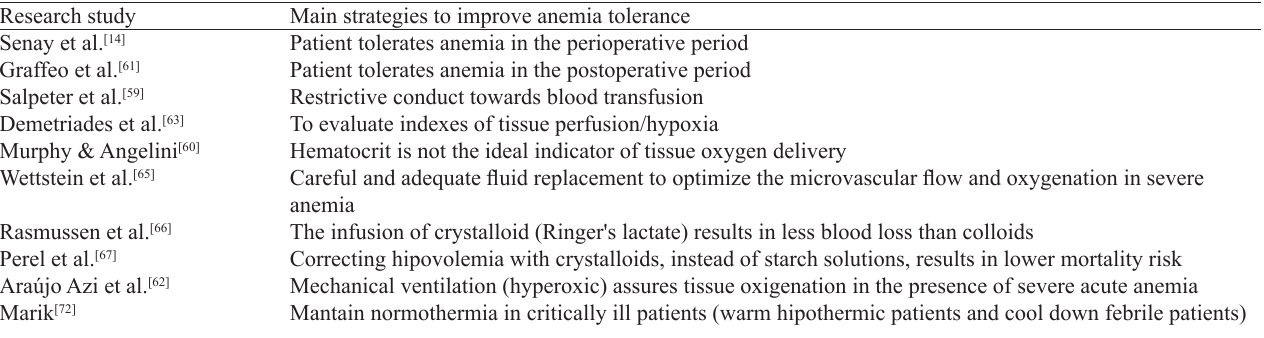
Table 3. Main strategies to improve anemia